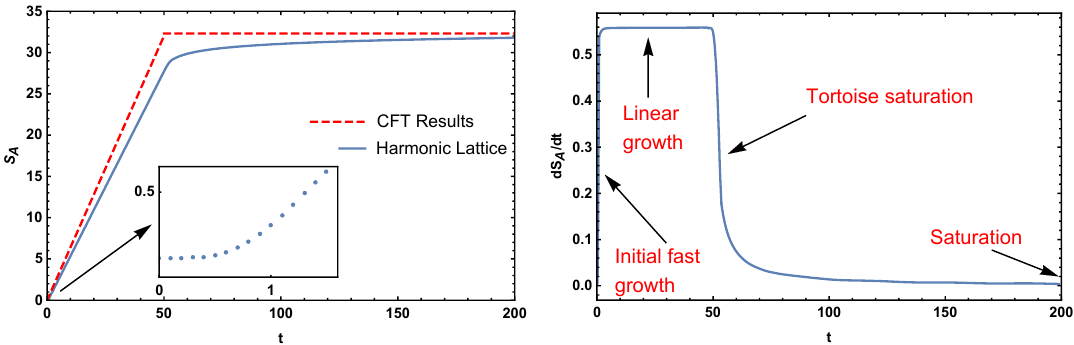
Figure 1 . Numerical data showing entanglement entropy as a function of time in a theory with relativistic scaling. Left: CFT prediction vs. harmonic lattice simulation with periodic BC. The numerical results correspond to ‘ = 100 and m 0 = 1 ; m = 10 (cid:0) 6 . Right: time derivative of EE during the thermalization